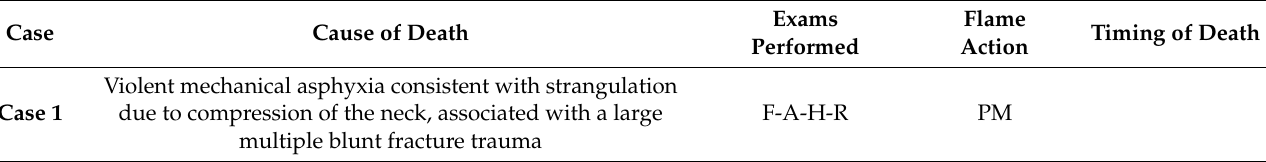
Table 7. Another graphical schematization of the deduced causes of death in every case and the type of exam carried out. It details cases of largely charred corpses and specifies whether death occurred before (while alive) or after (postmortem) the fire event. Here, A/EE means autopsy